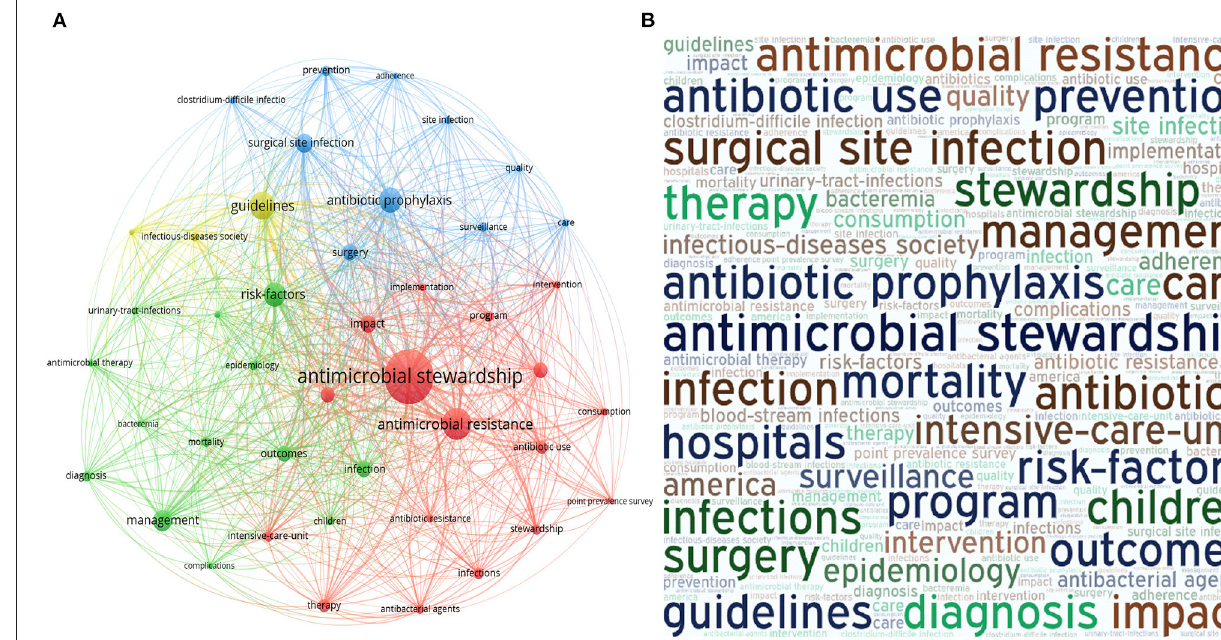
FIGURE 3 | Bibliometric analysis of the keywords in publications of AMS in surgery. (A) Co-occurrence of keywords. Various nodes represent the frequency of different keywords occurrences. Curves between the nodes reveal their co-occurrence in the same publication. When the greater the number of co-occurrence in two keywords, the distance between two nodes are shorter. Among all keywords, “antimicrobial stewardship” linked with 718 other keywords (total link strength: 3,137) was the most frequency keywords. (B) Word cloud. 49 keywords which occurred more than 15 times were enrolled. Font size indicate the frequency of keywords